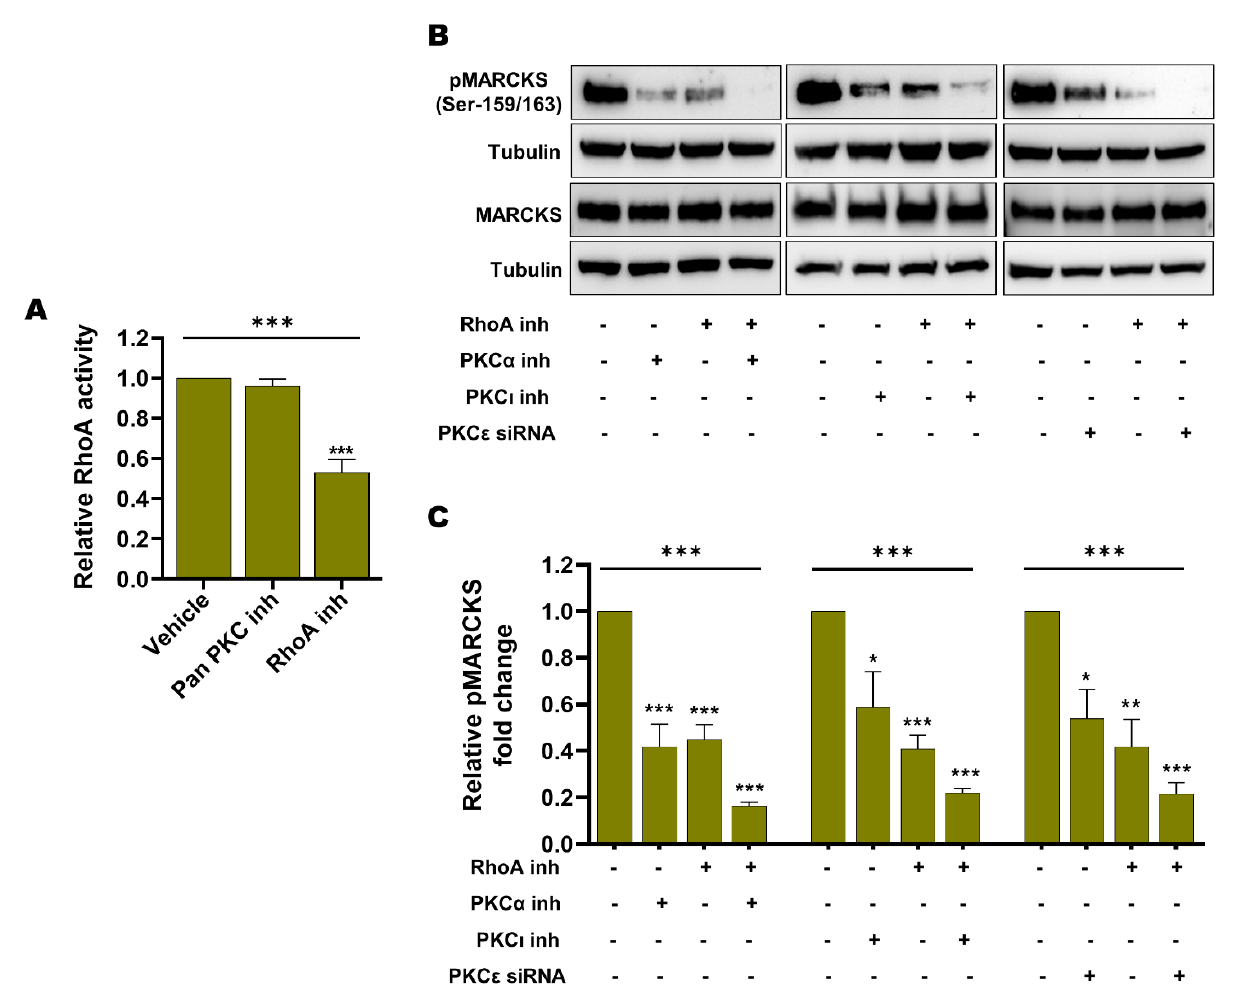
Figure 8. Enhanced RhoA activity and enhanced PKC activity are independent events contributing to the increased level of active phospho-MARCKS in BRAFi-R melanoma cells. ( A ) Graph showing RhoA activity as measured by a G-LISA kit in A375-R2 cells treated with either the pan-PKC inhibitor Gö6983 (50 nM) or the RhoA inhibitor Rhosin (10 µM) for 1 hr. Activity levels were normalized to those in vehicle-treated BRAFi-R A375-R2 cells and calculated from 4 independent experiments, and the values are presented as the means ± SEMs. ( B ) Western blot showing the pMARCKS (Ser-159/163) and total MARCKS levels in A375-R2 cells treated with the PKC α inhibitor (100 nM), the PKC ι inhibitor (1 µM) or PKC ε siRNA (100 nM) individually or in combination with the RhoA inhibitor Rhosin (100 µM). Tubulin was used as the loading control. Representative blots from 4 independent experiments are shown. ( C ) Graph showing the densitometric analysis of the pMARCKS level in A375-R2 cells as shown in panel B. These values were normalized to the value of the tubulin loading control from the same sample. The calculated pMARCKS/tubulin ratios were normalized to those in vehicle-treated BRAFi-R A375-R2 cells and are presented as relative fold changes. The data were calculated from 4 independent experiments and are presented as the means ± SEM. Statistical significance was estimated using ANOVA with Dunnett’s post hoc test for multiple comparisons; * p < 0.05, ** p < 0.01, *** p <